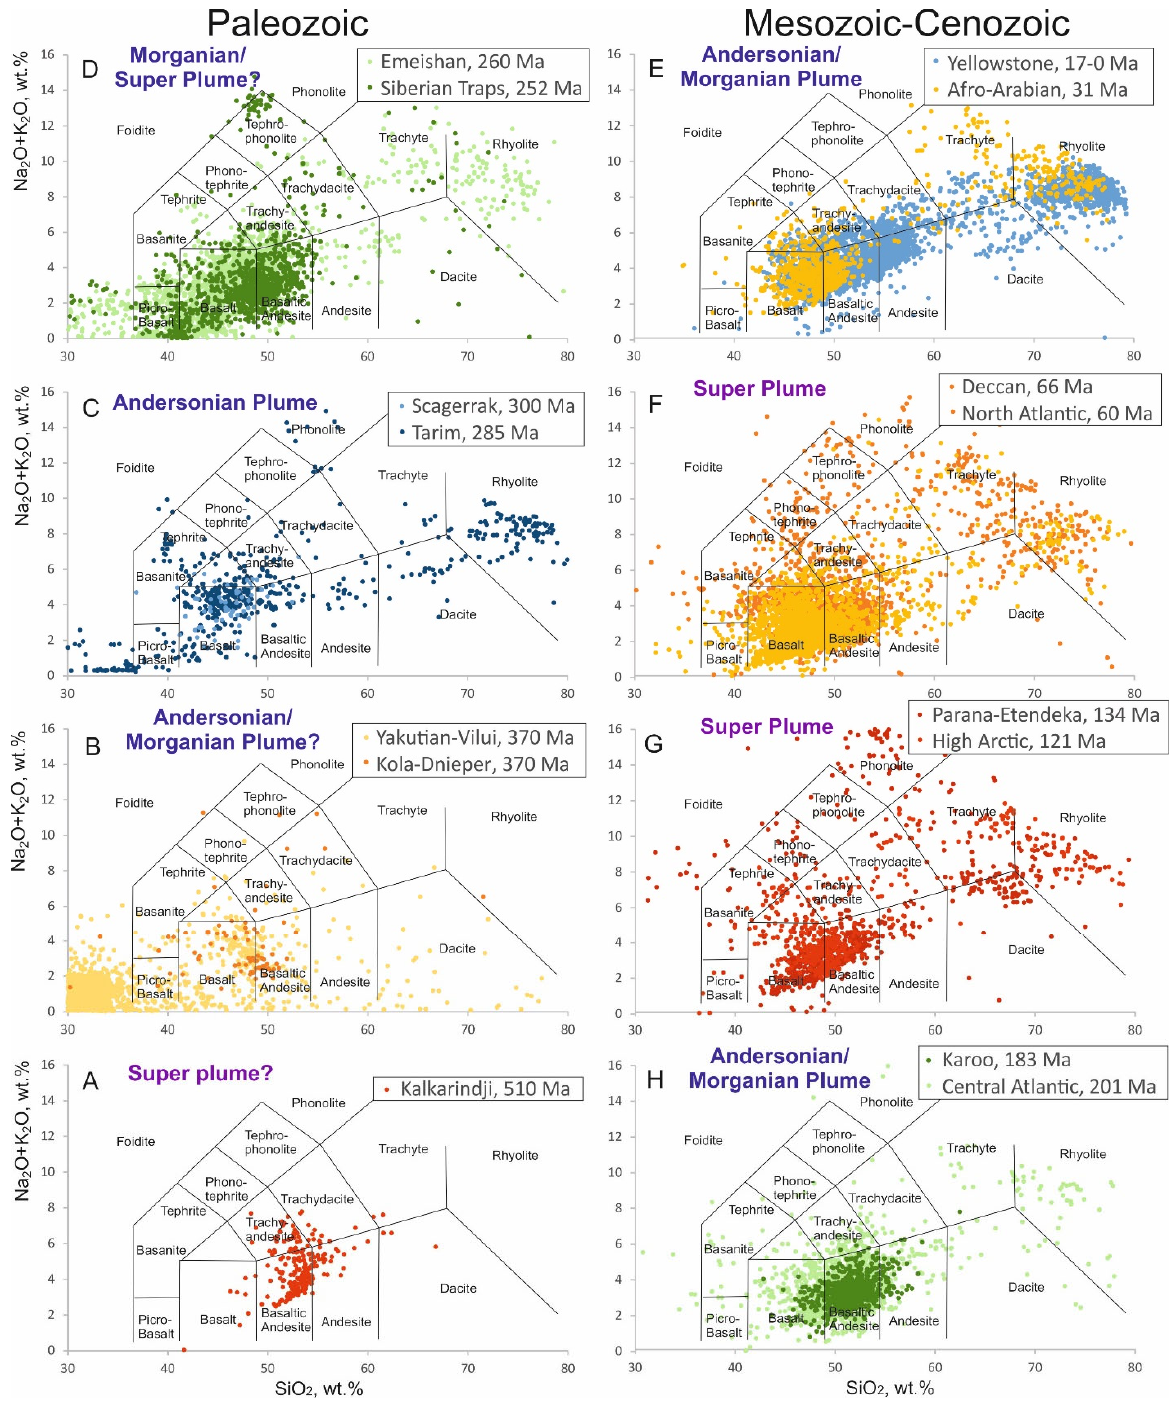
Figure 2. TAS diagrams for distinguishing the selected LIPs between the Andersonian, Morganian and Super plumes according to the discrimination by Zang et al. [18]. Plots of the LIPs attributed to the galactic spring, summer, autumn, and winter times (see Figure 1) are colored in green, red, yellow–orange, and blue, respectively. Data sources are cited in Section 2. ( A ) Kalkarindji; ( B ) Yakutian ‐ Vilui and Kola ‐ Dnieper; ( C ) Scagerrak and Tarim; ( D ) Emeishan and Siberian Trips; ( E ) Yellowstone and Afro ‐ Arabian; ( F ) Geccan and North Atlantic; ( G ) Parana ‐ Etendeka and High Arctic; ( H ) Karoo and Central Altantic.